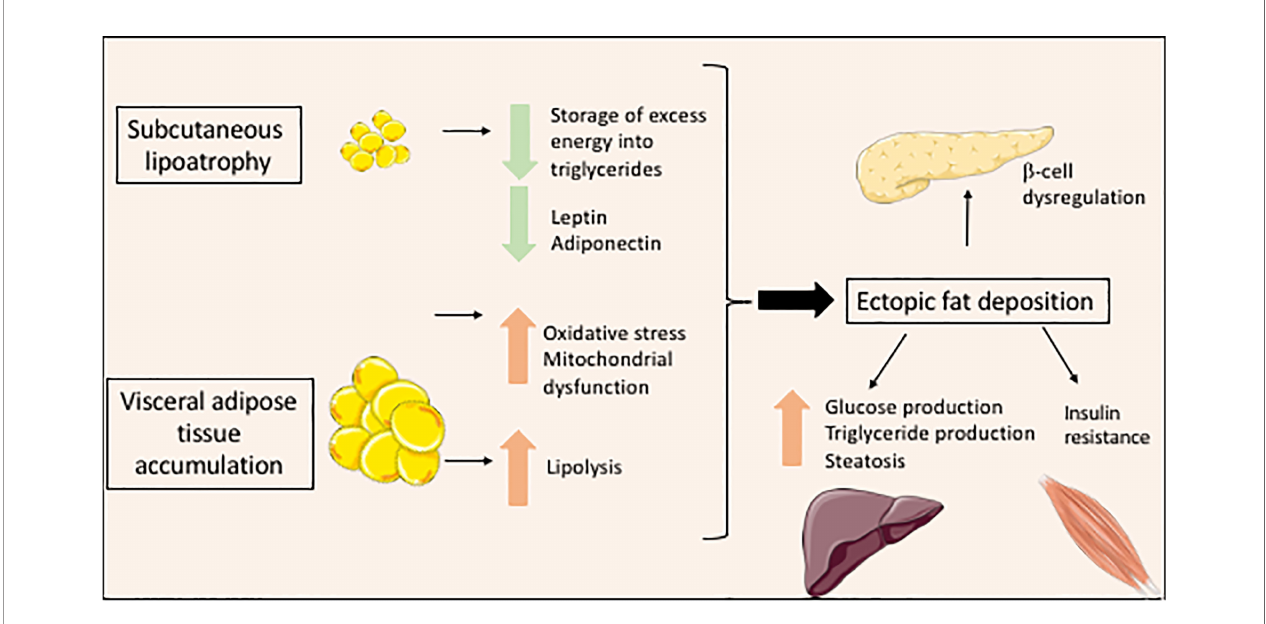
FIGURE 2 | Metabolic consequences of lipodystrophy leading to cellular